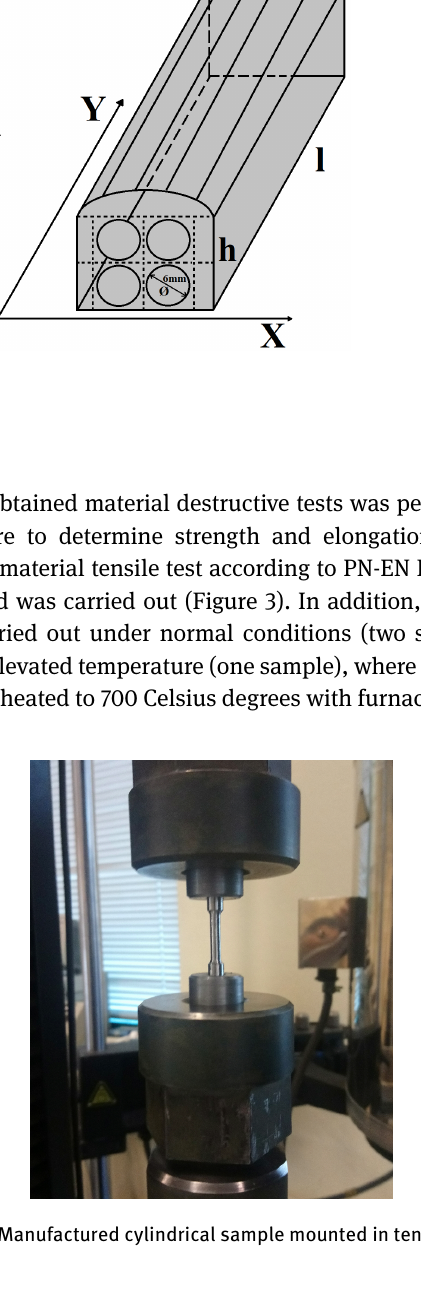
Manufactured specimens were stretched by increas- ing load force until failure (Figure 4) using Instron 4500 testing machine. Sample internal diameter was 3mm with measuring length equal to 18mm. The rupture of a speci- men was obtained at loading force equal approximately to 4.9 and 4.85 kN in normal conditions (Figure 5a), and 4.3 kN at elevated temperature (Figure